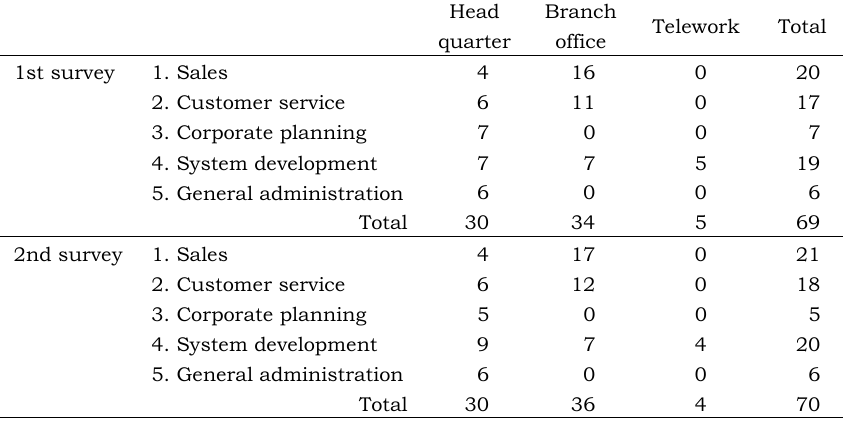
Table 1. Job type and place of